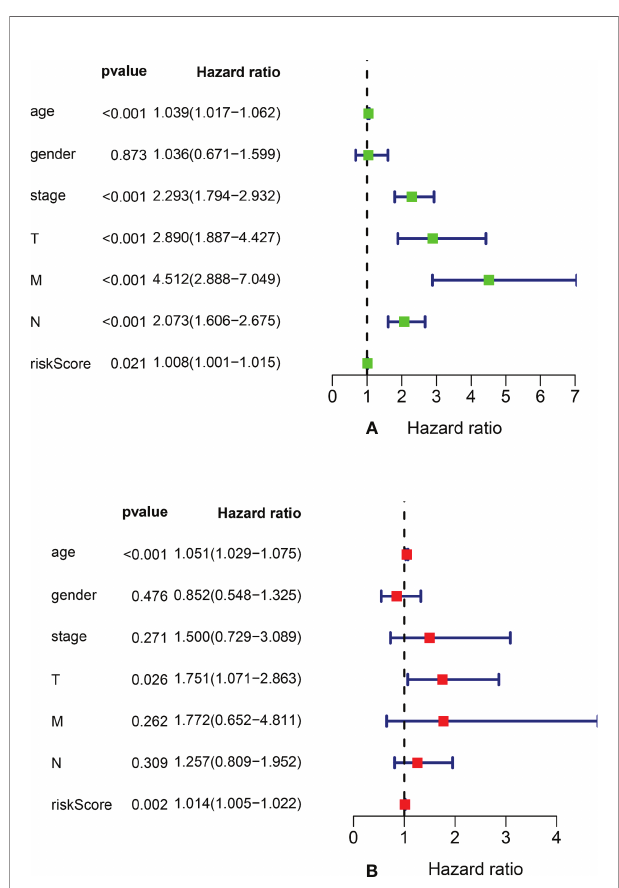
FIGURE 6 | Forest plots of univariate and multivariate Cox regression analyses of clinicopathological parameters (age, gender, clinical stage, and TNM stage) and risk scores associated with 5-year overall survival. (A) Forest plot of univariate Cox regression analysis. (B) Forest plot of multivariate Cox regression analysis.